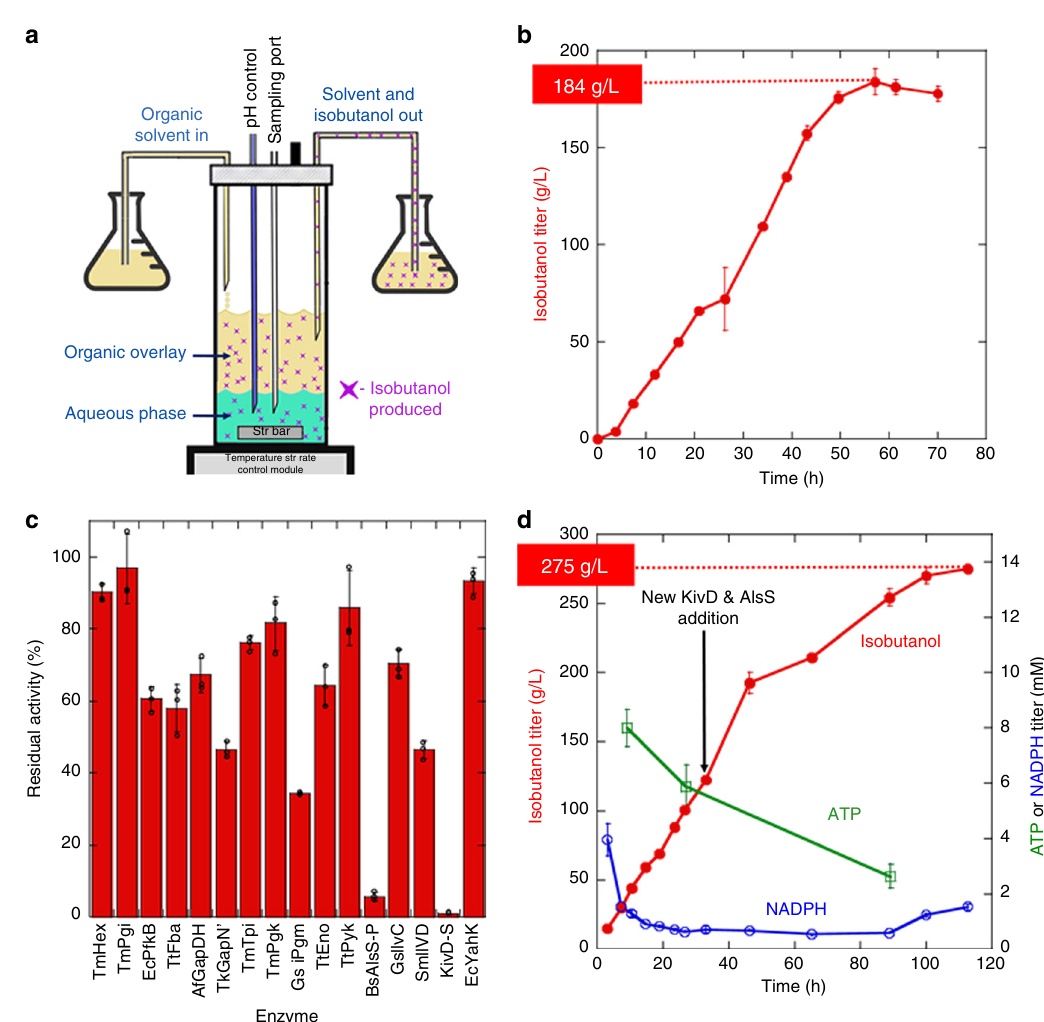
Fig. 5 Bioreactor system with continuous extraction. a Bioreactor set up for continuous product extraction. Phenetole in continuously added from a reservoir and simultaneously extracted at the same rate. The extracted layer is collected in a separate container. b Isobutanol titer over time using the continuous extraction system. c Residual activity of enzymes after 70 hours of incubation. d Isobutanol titer over time with the addition of a second bolus of KivD-S and BsAlsS-P at 33 h, the enzymes that become inactivated after 70 h. The ATP (green) and NADPH (blue) concentrations in the reaction are also shown as a function of time. Error bars in all panels are the standard deviation of technical triplicates. Open circles in panel c show the data points. Source data underlying Fig. 5b – d are provided as a Source data fi